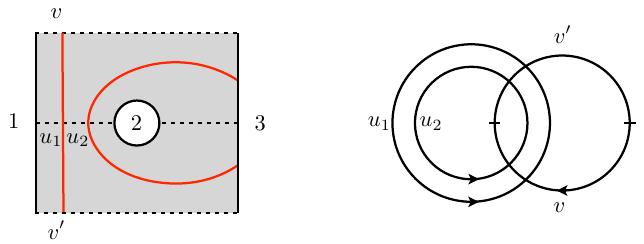
Figure 17 . The leading wrapping contribution comes from a single wheel surrounding either operator 1 or 2. The short-distance singularity can be handled by point splitting the rapidity along a mirror cut, as shown here for a wheel around operator 1. The divergence appears then as a simple pole 1 =(cid:15) in the regulator (cid:15) = v 0 v 0. The (cid:12)nite part (cid:15) 0 can be understood as dressing with (cid:24) (cid:0) (cid:24) (cid:24) (cid:12)nite-size corrections the spectator magnons in the channel 12. On the right panel, we show the contraction of R matrices yielding the matrix part for the point-split process. The (cid:13)avours circulate freely along the loops, but the rapidity jumps from its incoming to outgoing values, v 0 and v , along one of